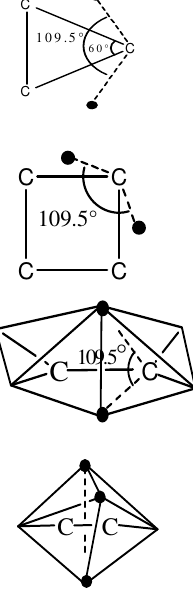
Figure 6. Presentation and calculation of L -strain for some organic